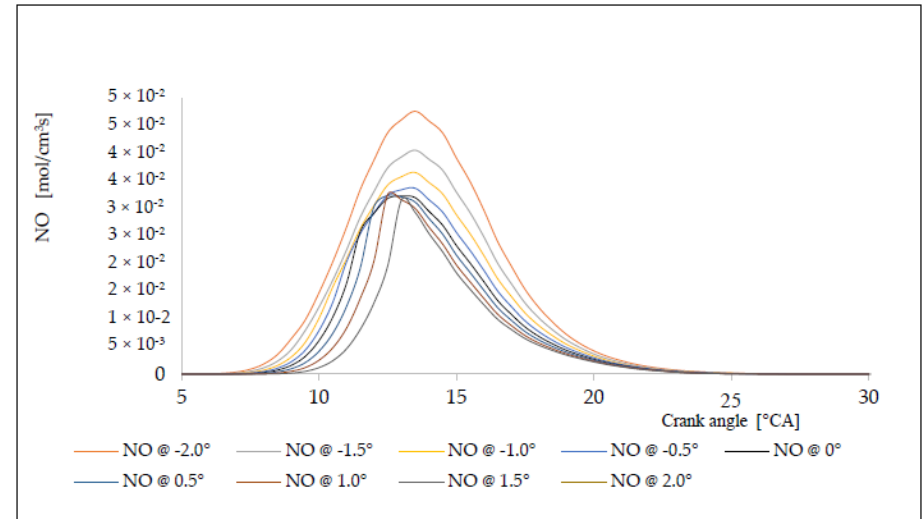
Figure 8. Dependence of NO concentration on the change in injection timing at 50% MCR [22].